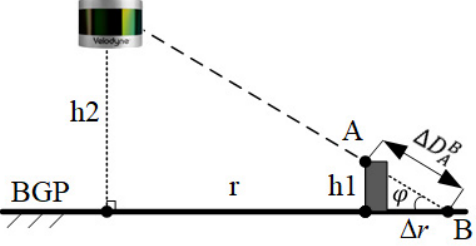
Figure 5. Schematic diagram of distinguishing abnormal ground points (AGPs) and normal ground points (NGPs).